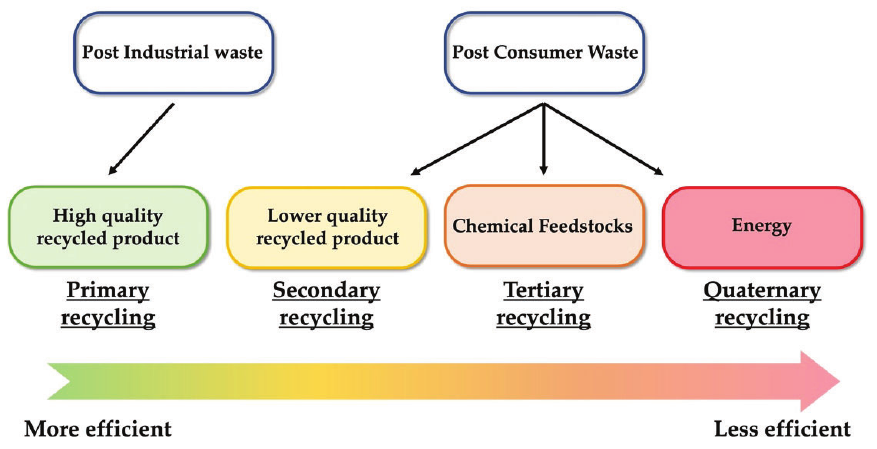
Figure 2. Common classification of usual recycling strategies for plastic wastes.